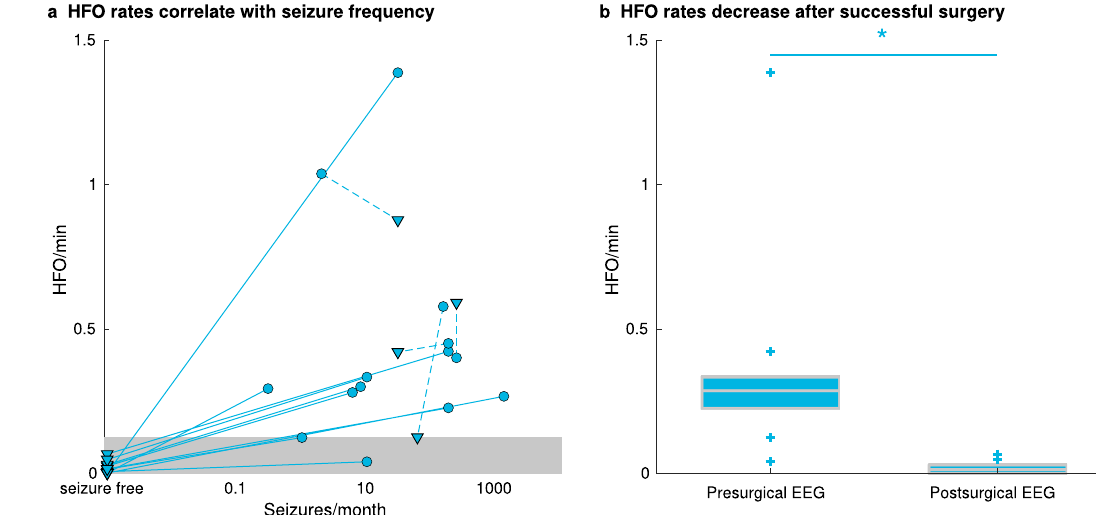
Figure 3. Scalp HFO rates correlate with seizure frequency and decrease after successful epilepsy surgery. ( a ) Scalp HFO rates in HFO area channels correlate with seizure frequency (Spearman’s rho 0.740, p < 0.001). Presurgical HFO rates are indicated by circles and postsurgical HFO rates by triangles. Pre- and postsurgical HFO rates are connected by a solid line for the patients for whom postsurgical seizure freedom was achieved (Engel I) and by a dotted line for patients for whom postsurgical seizure freedom was not achieved (Engel II–IV). The gray area on the bottom of the graph represents the HFO range corresponding to seizure freedom, based on the 0.124 HFO/min threshold, as established by the ROC curve. 17 of 28 scalp EEG recordings were classified correctly as true positive, ten as true negative, and only one was a false negative. ( b ) Median scalp HFO rates in HFO area channels decrease after surgery in the patients for whom postsurgical seizure freedom was achieved (Wilcoxon signed-rank: p = 0.005, z = 2.803) from 0.287 HFO/min (iqr 0.107) in the presurgical to 0.015 HFO/min (iqr 0.029) in the postsurgical